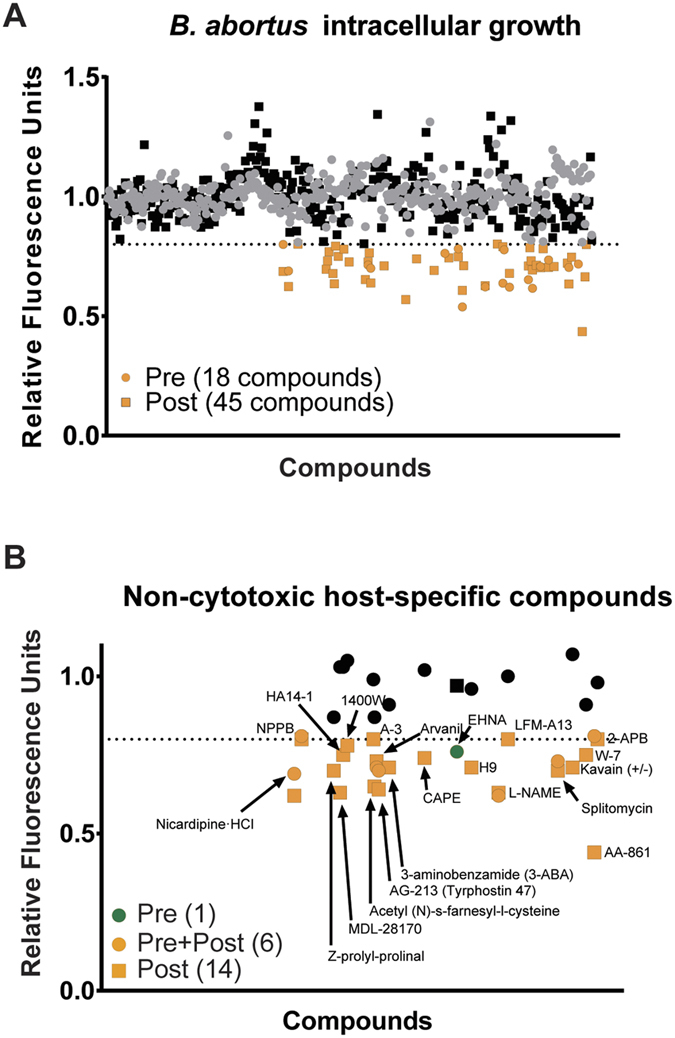
Identification of compounds that inhibit intracellular growth of B. abortus in a bulk human cell infection assay. Compounds from the ICCB bioactives library were arrayed into plates containing THP-1 macrophage-like cells infected with wild-type B. abortus constitutively expressing mCherry. ICCB compounds are plotted sequentially along the X-axis; relative mCherry B. abortus fluorescence is plotted on the Y-axis in all graphs. Dotted line delineates 20% below the mean normalized fluorescence across all conditions; compounds that fall below this line were considered hits (orange). (A) Graph of B. abortus fluorescence (72 hours post-infection) in the presence of each ICCB compound in cells treated pre-infection (circles) or post-infection (squares) as described in Methods. (B) Twenty-one non-cytotoxic compounds that inhibit intracellular growth of B. abortus presumably by targeting the host. Orange-filled circles represent compounds that inhibited B. abortus infection by 20% or more. Green-filled circle represents a single compound that in our screen was found to be effective only when applied pre-infection.